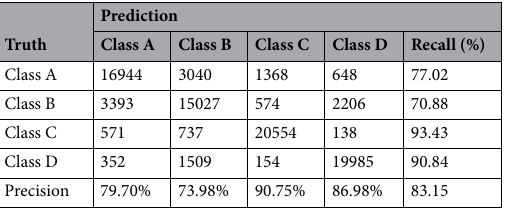
Table 4. Confusion matrix of samples. The accuracy is listed at the bottom-right corner.